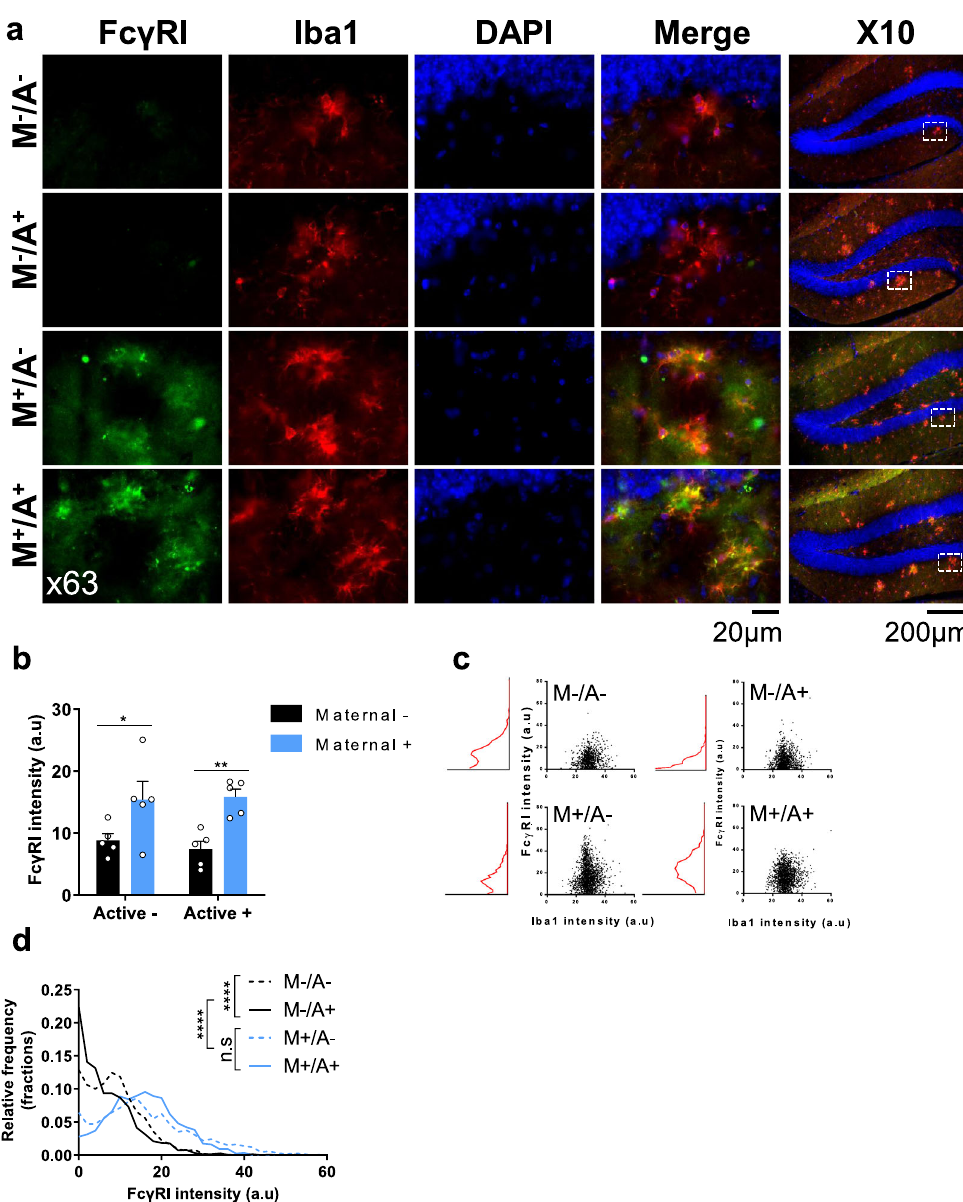
Fig. 6 Maternal vaccination upregulates microglial FcRs expression. Microglial Fc γ RI protein expression was quanti fi ed using immuno fl uorescence following maternal and active vaccination at 5 m of age ( n = 5 ). a Fc γ RI expression was assessed using double-labeled immuno fl uorescence in Iba1 + microglia, using the x10 and x63 objectives for visualizing and quanti fi cation, respectively. b Quanti fi cation of Fc γ RI signal intensity among microglia. c Scatter plot and intensity distribution Fc γ RI signals in Iba1 + cells. d Overlay and comparisons of Fc γ RI expression distribution. * P < 0.05, ** P < 0.01, **** P < 0.0001, two-way ANOVA, corrected two-sample Kolmogorov – Smirnov test, data are presented as mean ±